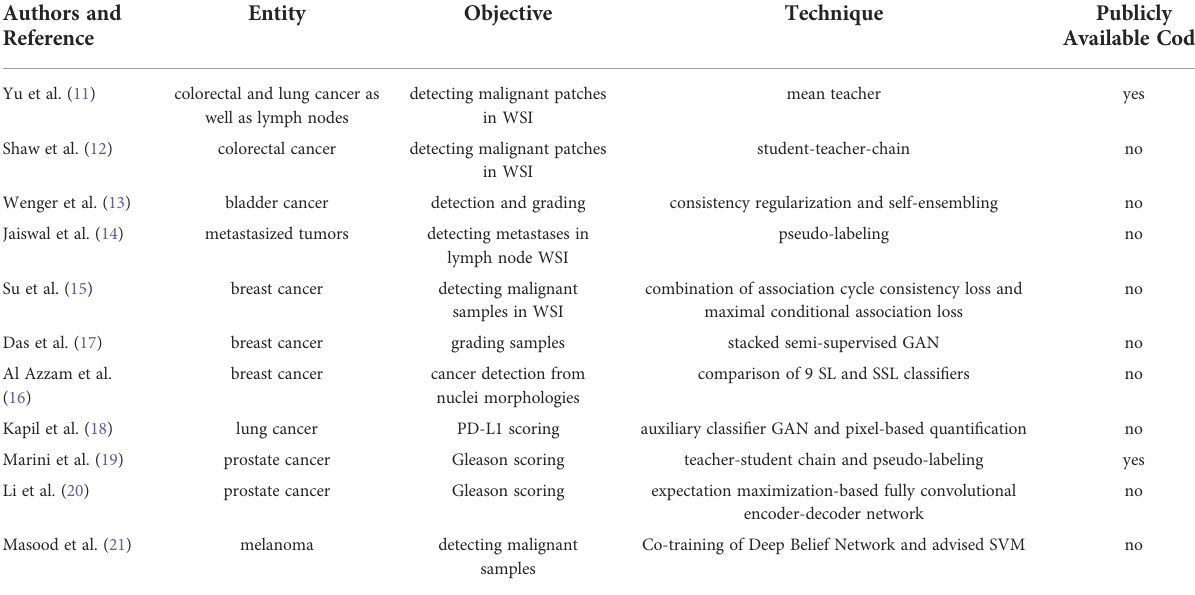
TABLE 1 Overview of Studies on Semi-Supervised Learning in Histopathology. Authors and